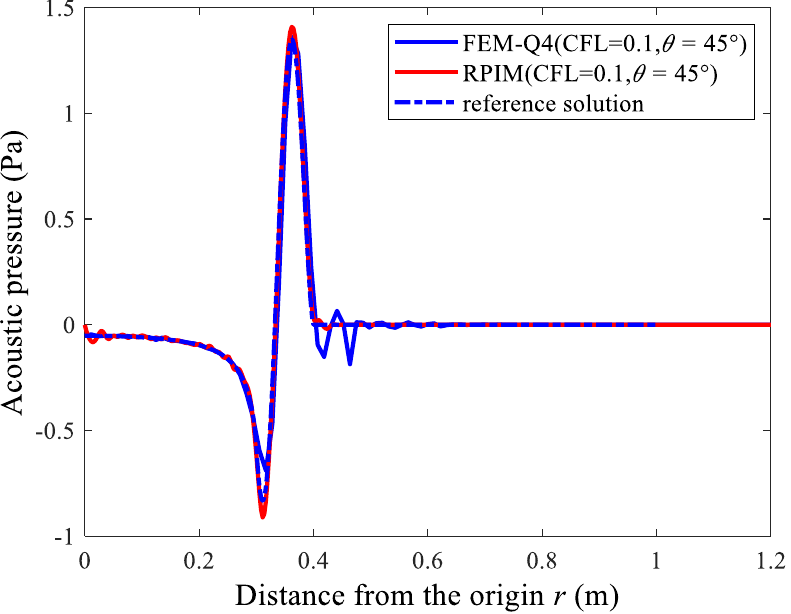
Figure 14. The transient responses of the acoustic pressure distributions from different methods for the two-dimensional scattering problem when the time point t = 0.4 s.